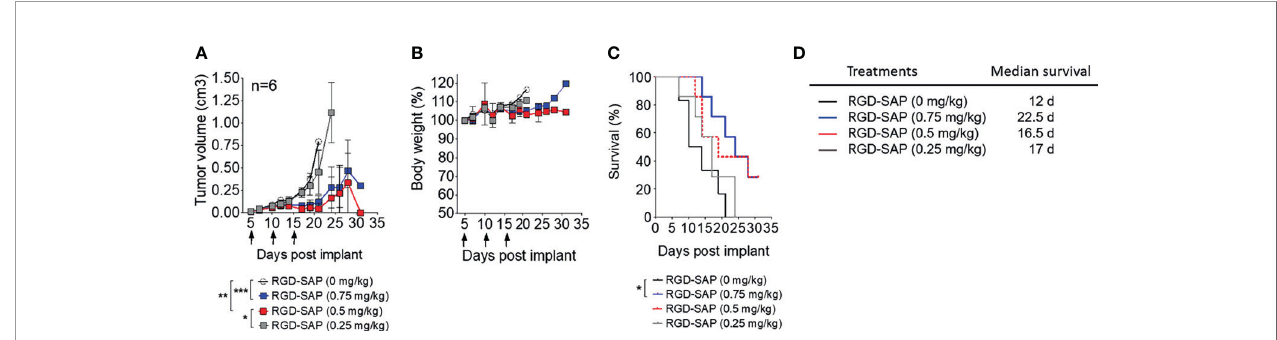
FIGURE 5 | Dose dependent effects of RGD-SAP on tumor growth in a subcutaneous syngeneic bladder cancer mouse model. (A) MB49 cells were subcutaneously implanted in 7-week-old C57BL/6 WT female mice (n=6/group) were treated i.v. with the indicated doses of RGD-SAP every 5 days after tumor implantation for three times (arrows). Tumor volumes (mean ± SD) are shown. *p < 0.05; **p < 0.01; ***p < 0.001 by using one-way ANOVA test. (B) Animal weights are reported as percent of starting body weight (mean ± SD of 6 animals per group). (C) Kaplan – Meyer plot of animal survival and (D) the associated median survival time. Results from a Mantel – Cox two-sided log-rank test are shown when statistically signi fi cant (*p < 0.05) for RGD-SAP 0.75 mg/kg (blue line, hazard ratio 5.25; 95% CI, 1.19 – 23.10) versus vehicle (black